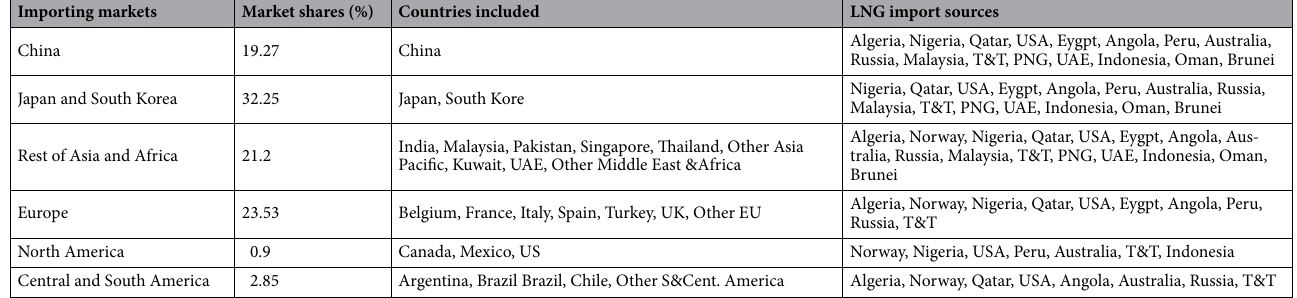
Table 1. Information on the six major import markets in